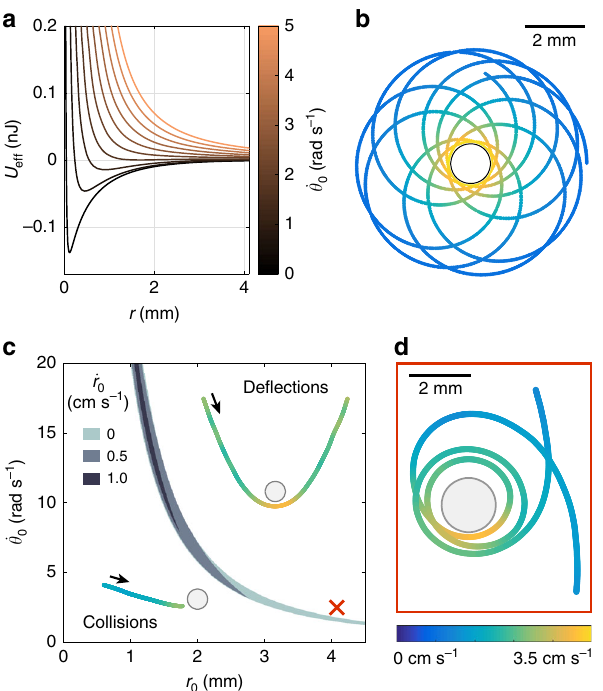
Fig. 4 The effect of energy loss. a Experimental trajectory of two particles with radii R 1 = 360 μ m and R 2 = 340 μ m. See also Supplementary Movie 9. b Energy loss Δ E of a two-drop system as a function of time (in blue). tot The modeled Δ E is plotted with a dotted line. c Trajectories of the two particles in the center of mass frame, with two different color codes for their velocities. The dotted lines are the modeled trajectories, calculated numerically by integrating (for each particle) a small friction force with Þ and a direction opposite to the particle velocity